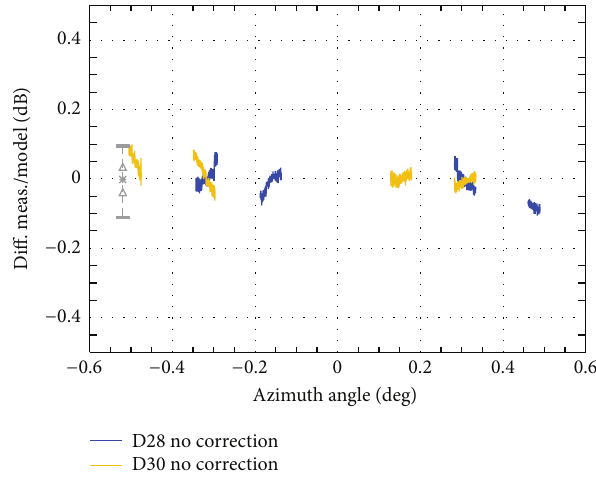
Figure 6: Difference between measurement on May 18, 2012, and model for the 3db region of the TOPS azimuth patterns, statistical values: grey/black. No pointing correction was needed for this data